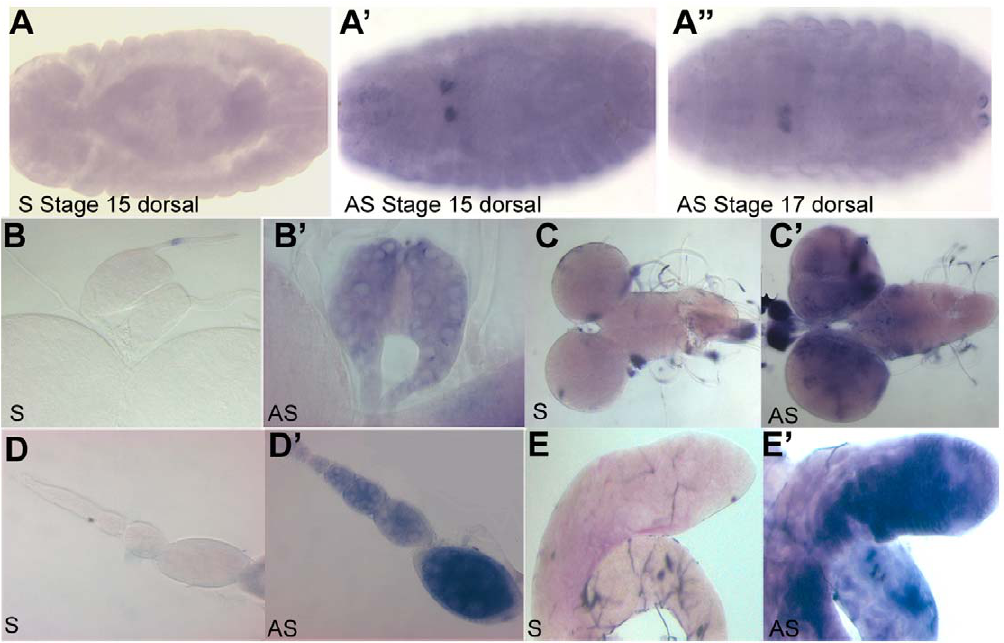
Figure 3. Expression of Rbp6 mRNA throughout development. (A–A’’) Rbp6 mRNA is detected in the prothoracic gland precursor cells in the embryo. Rbp6 mRNA is also detected in the third instar prothoracic gland (B–B’), the third instar larval brain (C–C’), the ovarioles of the adult ovary (D– D’) and in the adult testis (E–E’). S-Sense, A-Antisense.